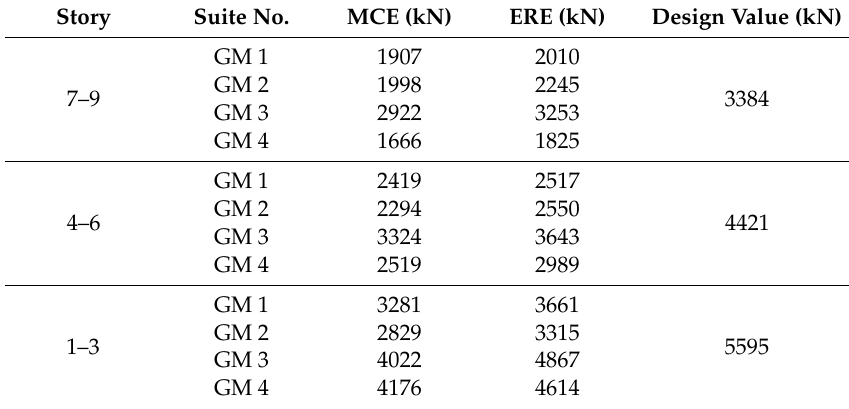
Figure 12. Maximum response envelopes of cable axial force under ( a ) GM 1; ( b ) GM 2; ( c ) GM 3; and ( d ) GM4. Table 4. Maximum axial force of cables under GMs 1-4.